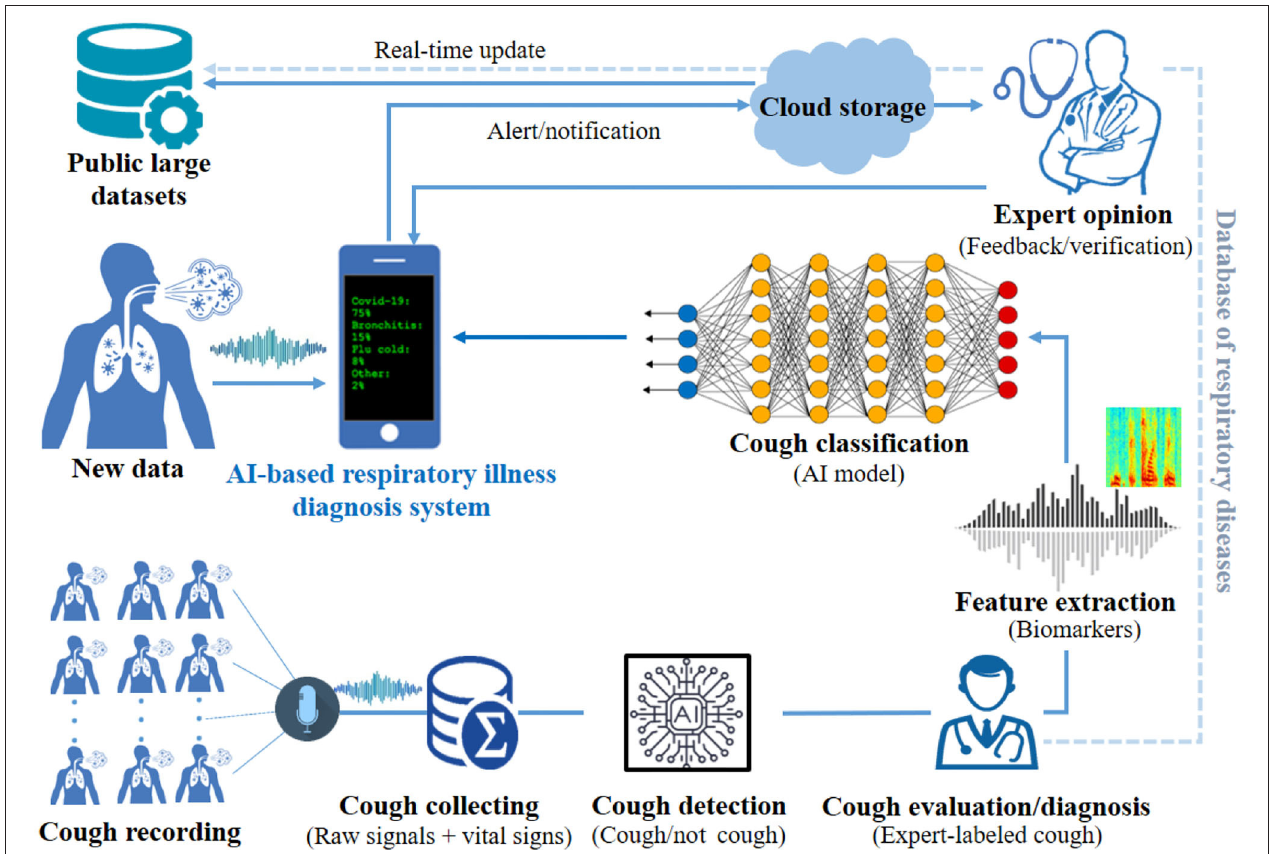
FIGURE 8 | Software design of the proposed AI-based cough diagnosis system. This system includes all phases with the possibility of sharing the collected stored database and the preliminary diagnosis results with researchers/medical doctors. The sharing approach of the database will lead to develop more robust open-source algorithms to be used for detecting and classifying any respiratory